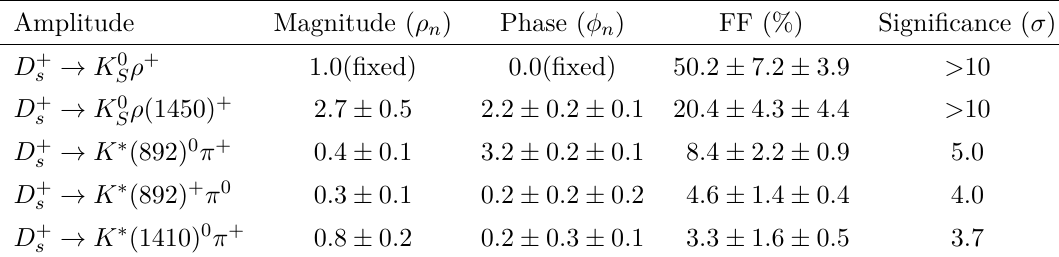
Table 4 . Magnitudes, phases, FFs, and significances for the amplitudes. The uncertainties in the magnitudes are statistical only. The first and the second uncertainties in the phases and FFs are statistical and systematic, respectively. The total FF is 86.9 % .